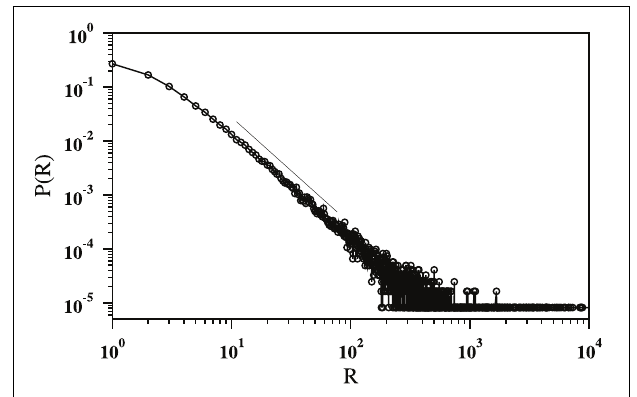
FIGURE 5 | The probability distribution of the radii of the individual agent’s circular orbits in the cyclic states. The power law has an exponent of τ = 1 . 99 ( 2 )